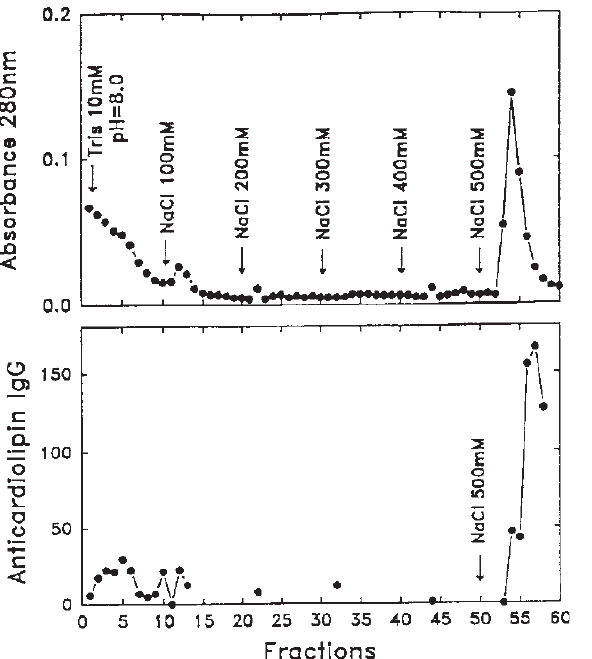
Figure 2. Results of affinity purification of anti-ATP IgG from a demented APS patient performed as described in the text. Elution buffers are indicated. Fractions collected from the column were assayed for total IgG content by spectroscopy (280nm, upper panel) and for anticardiolipin IgG (aCL) by ELISA (lower panel). The results indicate that most aCL could be eluted by the high salt (500mM NaCl) concentration and that no additional antibody was eluted by pH changes.